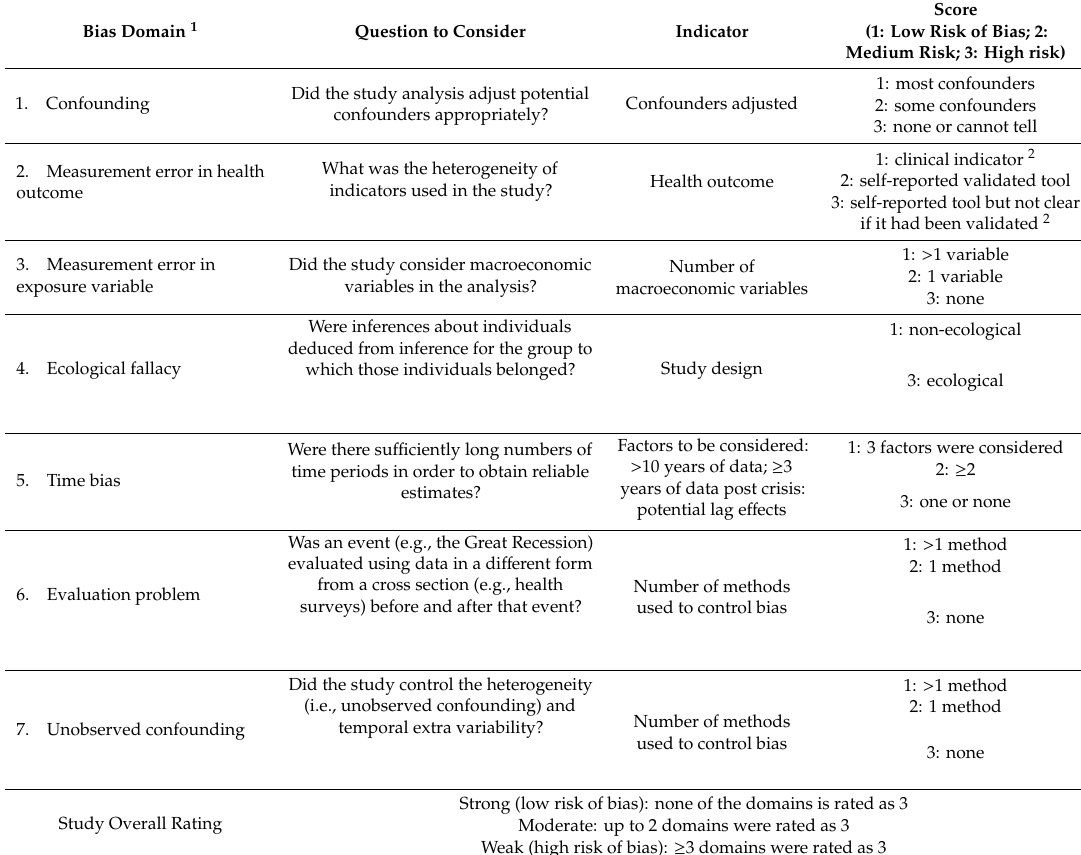
Table 1. Bias tool